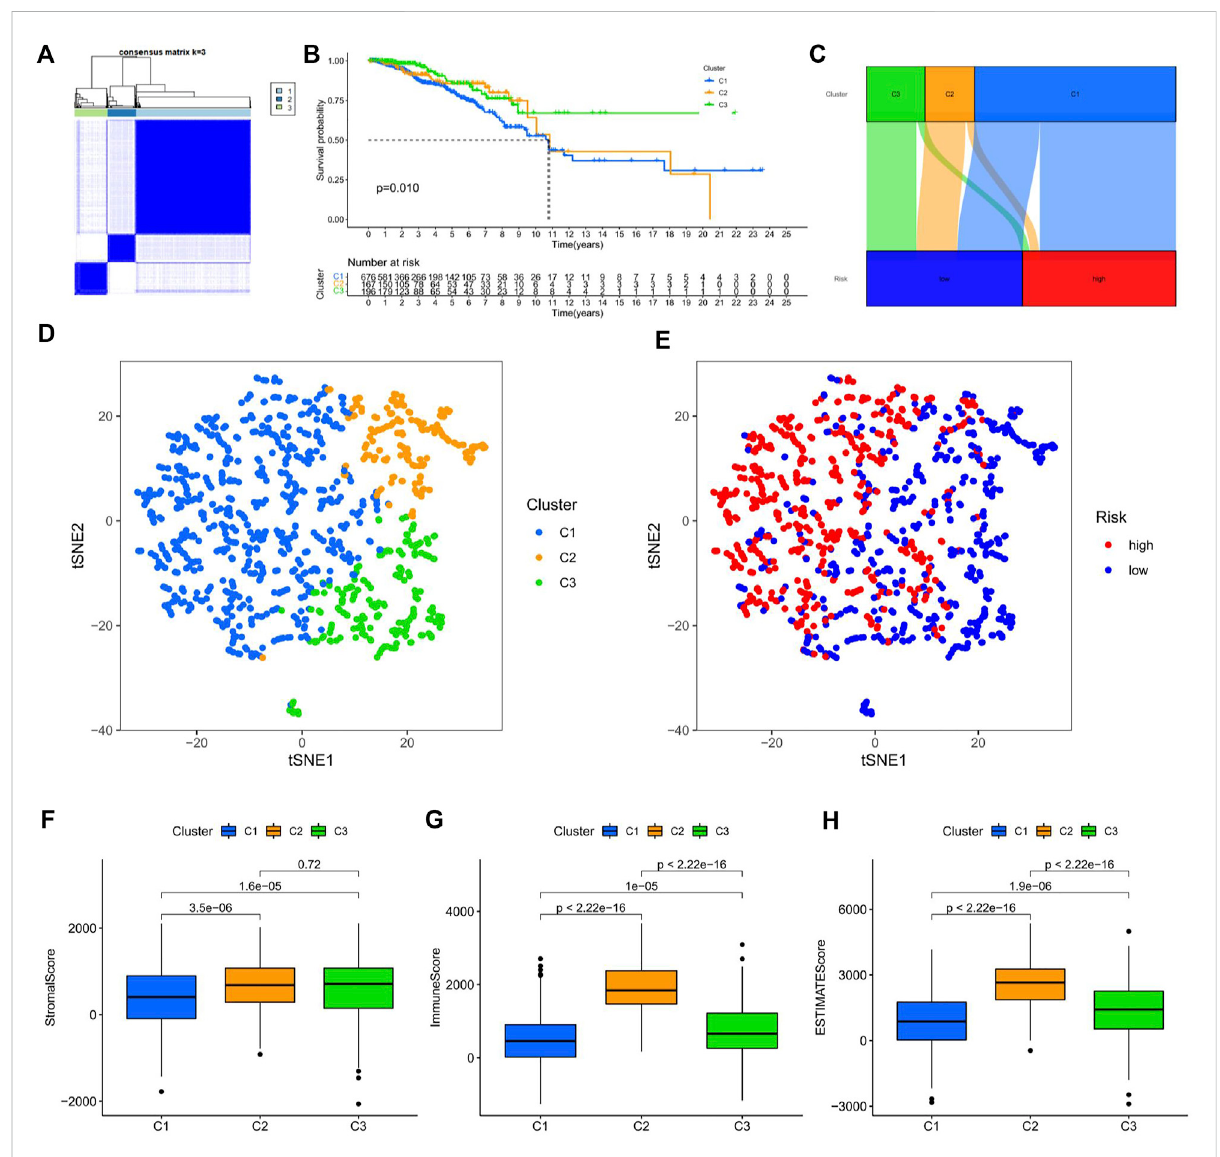
FIGURE 7 Survival, tSNE, and tumor microenvironment analysis of three distinct subgroups of BC divided by consensus clustering. (A) Consensus matrix with optimal k = 3. (B) Kaplan – Meier survival curves of BC patients ’ OS among the three different subgroups. (C) Sankey diagram of the relationship between thethreedifferentsubgroupsandriskscore. (D) tSNEanalysisamongthethreedifferentsubgroups. (E) tSNEanalysisbetweenthehigh-risk andlow-risk groups. (F – H) TheboxplotsforStromalScore (F) ,ImmuneScore (G) ,andESTIMATEScore (H) amongthethreedifferentsubgroups. tSNE, t-Distributed Stochastic Neighbor Embedding; BC, breast cancer; OS, overall